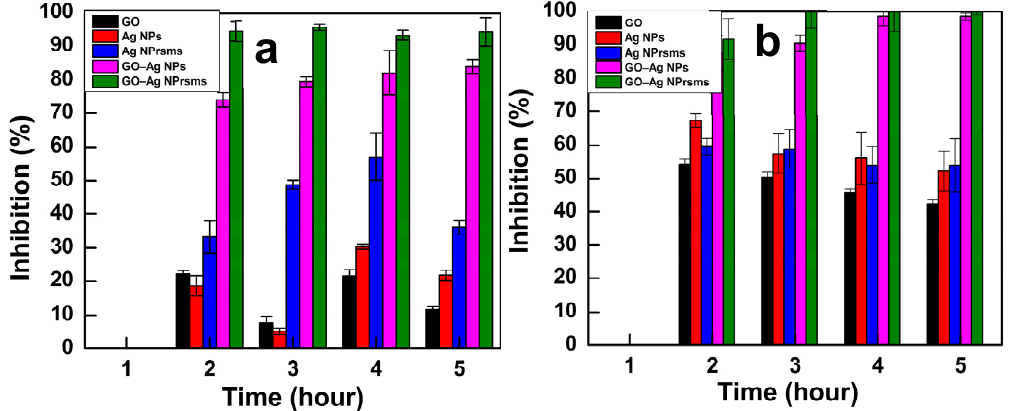
Figure 8. Inhibition values for E. coli ( a ) and S. aureus ( b ) after treatment with GO, Ag NPs, Ag NPrsms, GO-Ag NPs, and GO-Ag NPrsms nanomaterials at 100 µ g mL − 1 dose ( n = 3).